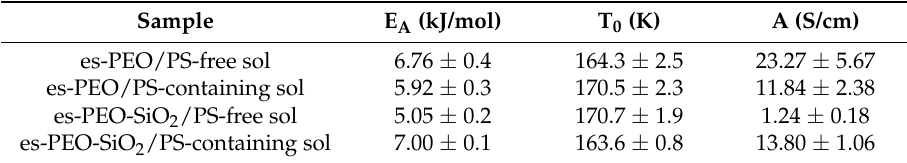
Table 3. Parameters of the VTF equation derived by fitting the curves in Figure